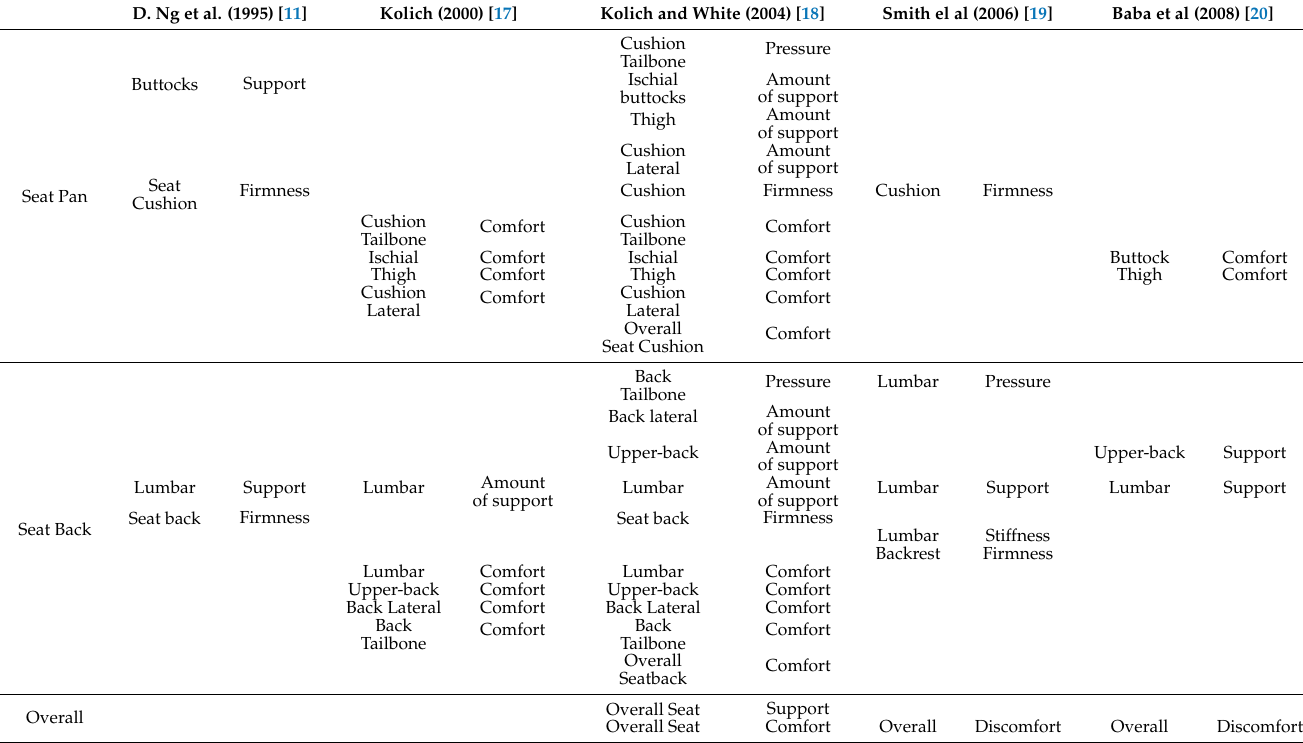
Figure 15. Test case, according to sitting posture. Table 2. Reference list of